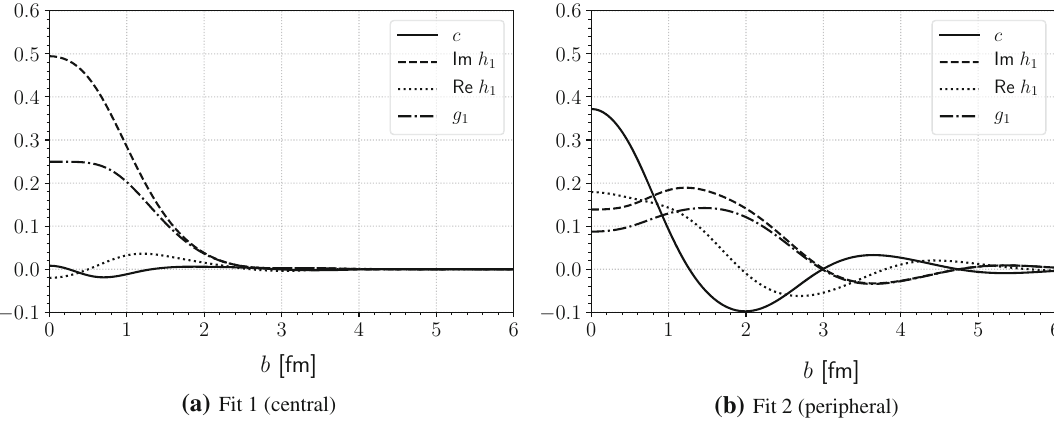
Fig. 12 Function c ( s , b ) and several other functions characterizing pp collisions in dependence on impact parameter at energy of 8 GeV corre- sponding to the central (Fit 1) and the peripheral (Fit 2) picture of elastic